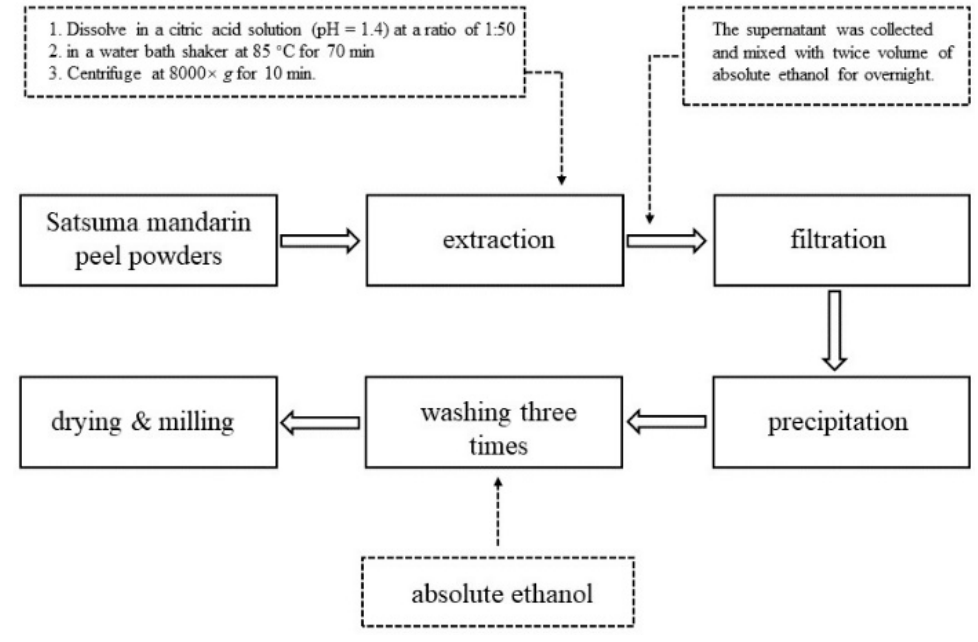
Figure 1. Flowchart of the pectin extraction process.